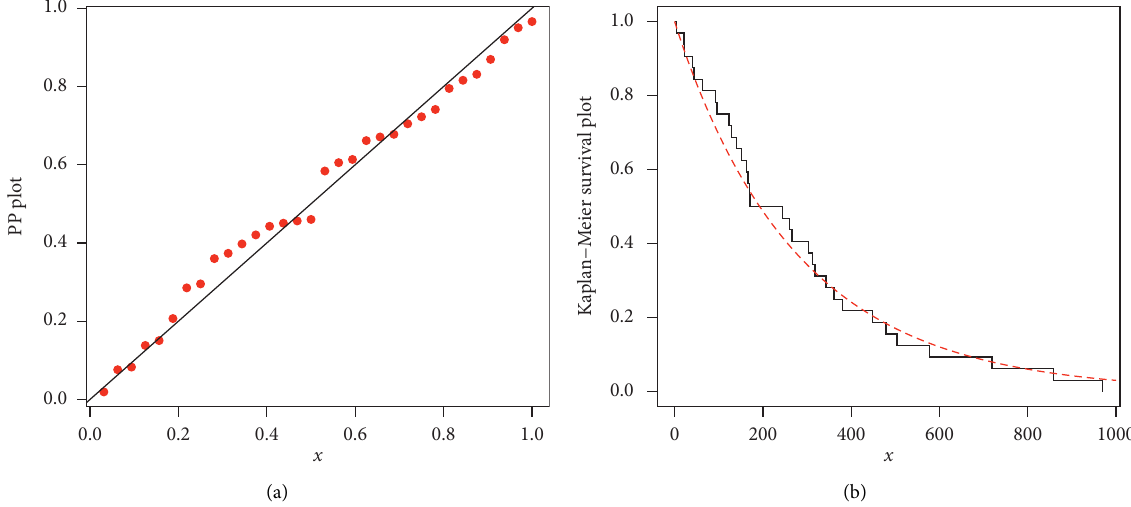
Figure 14: The PP and Kaplan–Meier survival survival plots of the HTBPT–Weibull distribution for the vehicle insurance loss data.